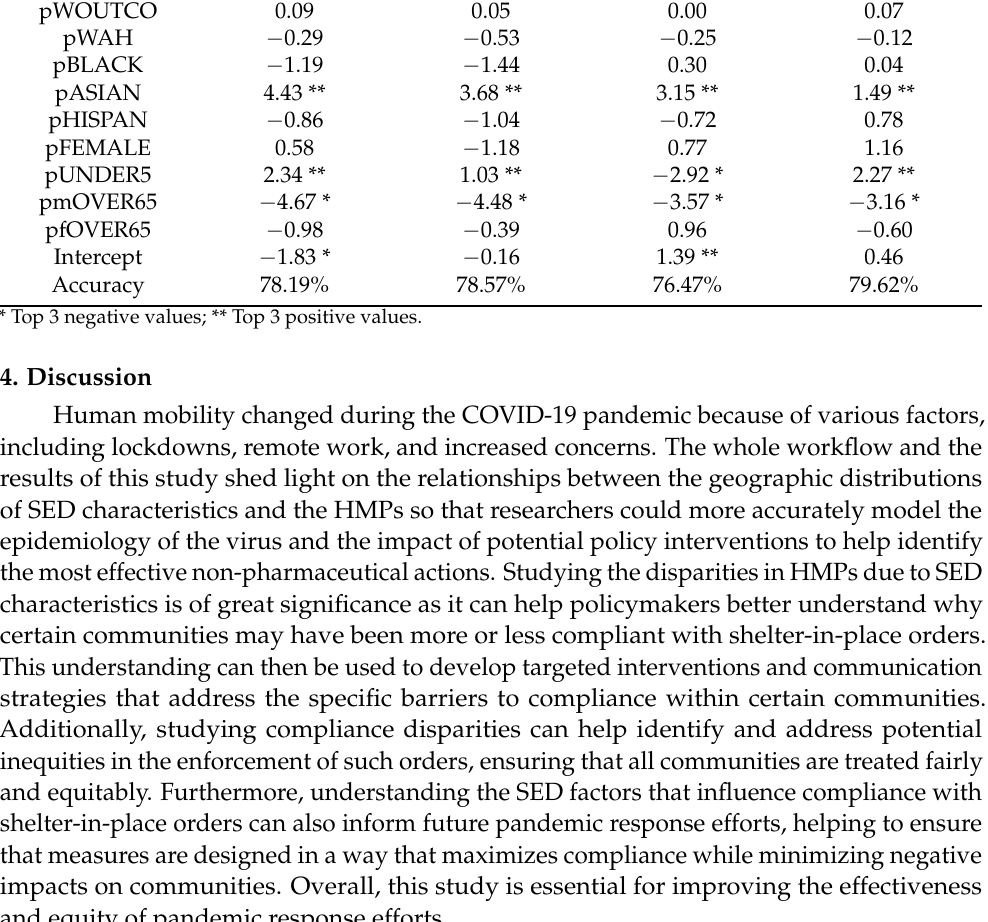
Table 3. LDA analyses of the dichotomized social mobility groups using social-economic and demographic variables. Full-Time Part-Time Stay-at-Home Home Dwelling Acronym Behavior Behavior Behavior Time pnoINS − 0.51 − 1.54 − 0.84 − 0.53 pservOCP − 0.62